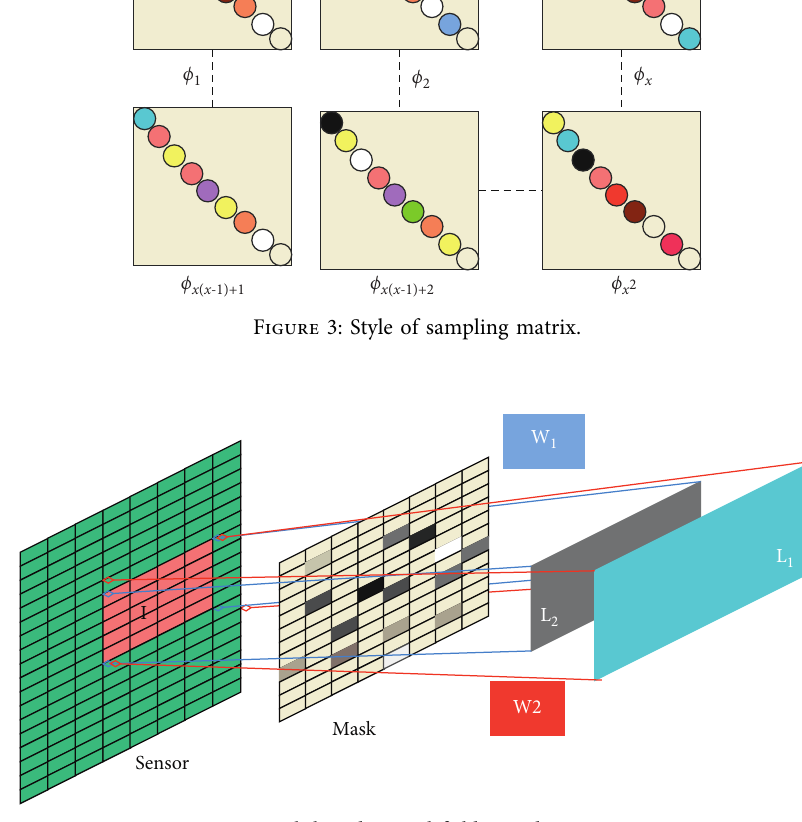
Figure 4: Mask-based optical field encoding